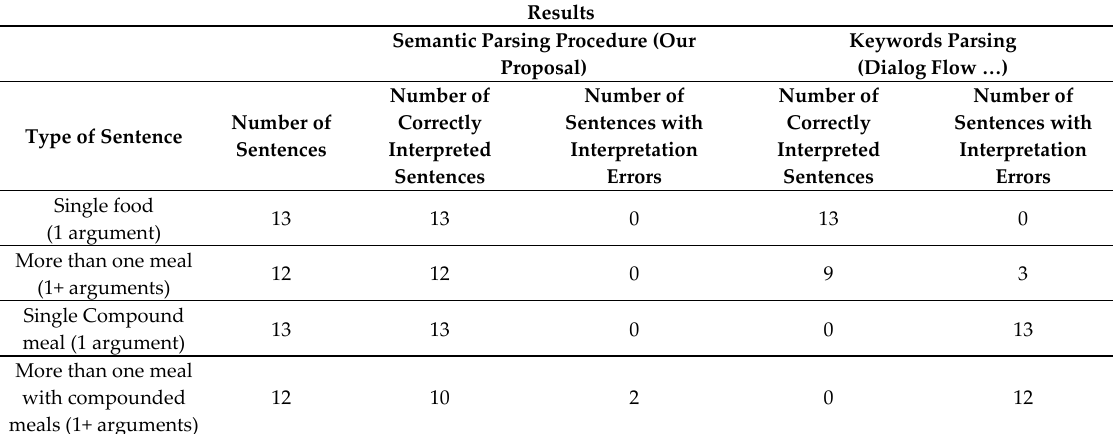
Table 1. Results of the validation process by sentence type in the nutritional